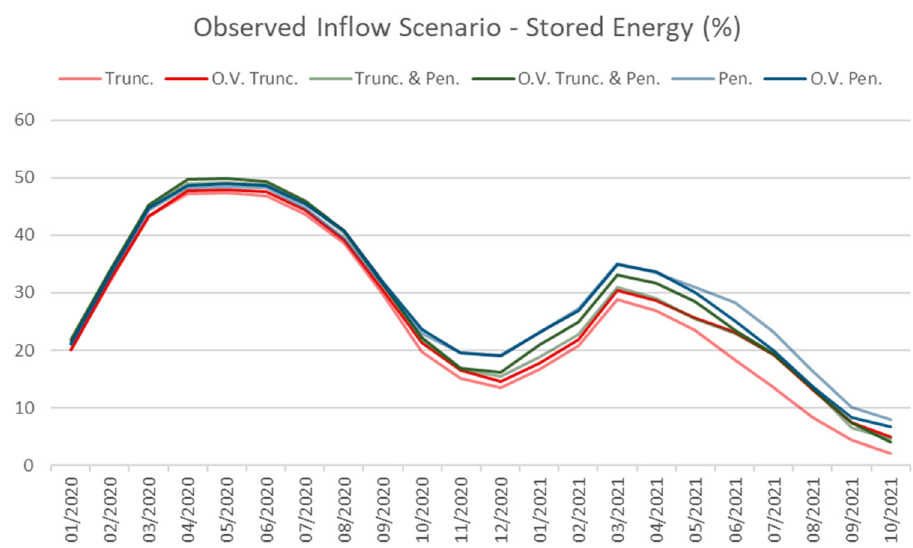
Figure 17. Stored energy obtained by the observed scenario in the maximum system’s stored energy